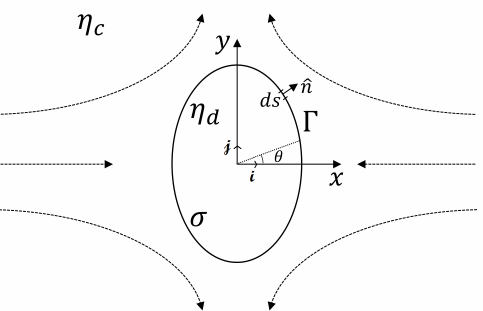
Figure 1. Schematic illustration of a droplet with initial radius R 0 deformed to an elliptical shape when subjected to a quasi-static extensional